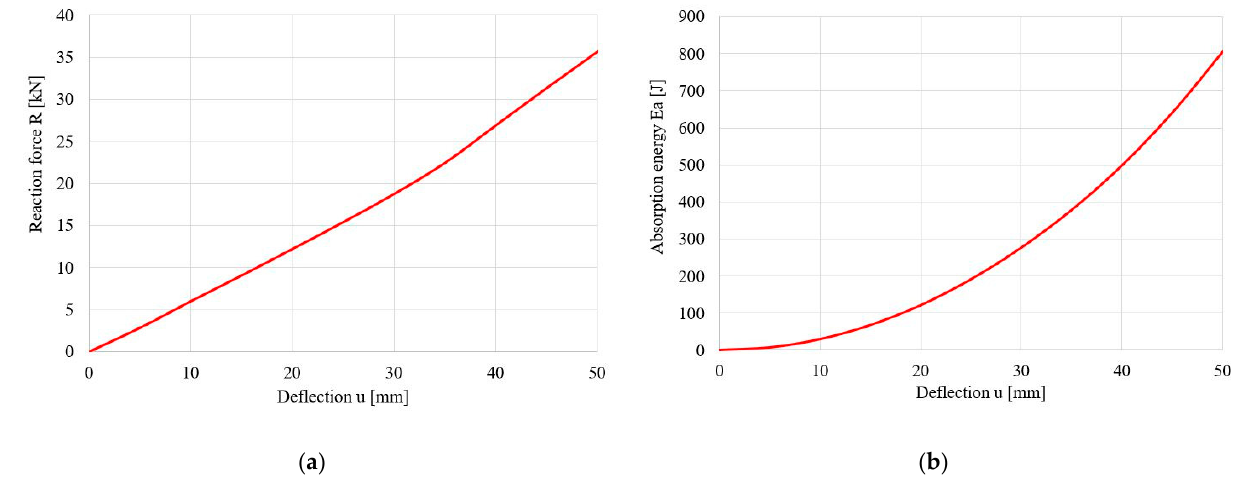
Figure 5. Numerically determined basic operational parameters of a cylindrical fender 100 mm × 50 mm × 500 mm. ( a ) Reaction force R (kN); ( b ) Absorption energy Ea ([J).